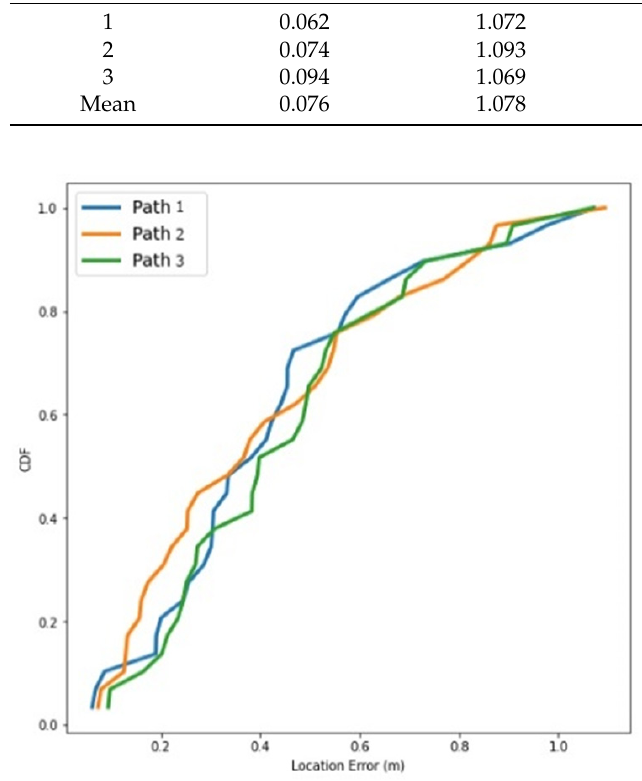
Figure 12. Distribution of cumulative errors in different routes. After coordinate constraint corrections, the improvements in the accuracy levels of the magnetic field and the ORB-SLAM system were 85.58% and 97.16%, respectively (Table 6). These findings indicated that the coordinate constraint correction method could effectively improve indoor positioning accuracy.